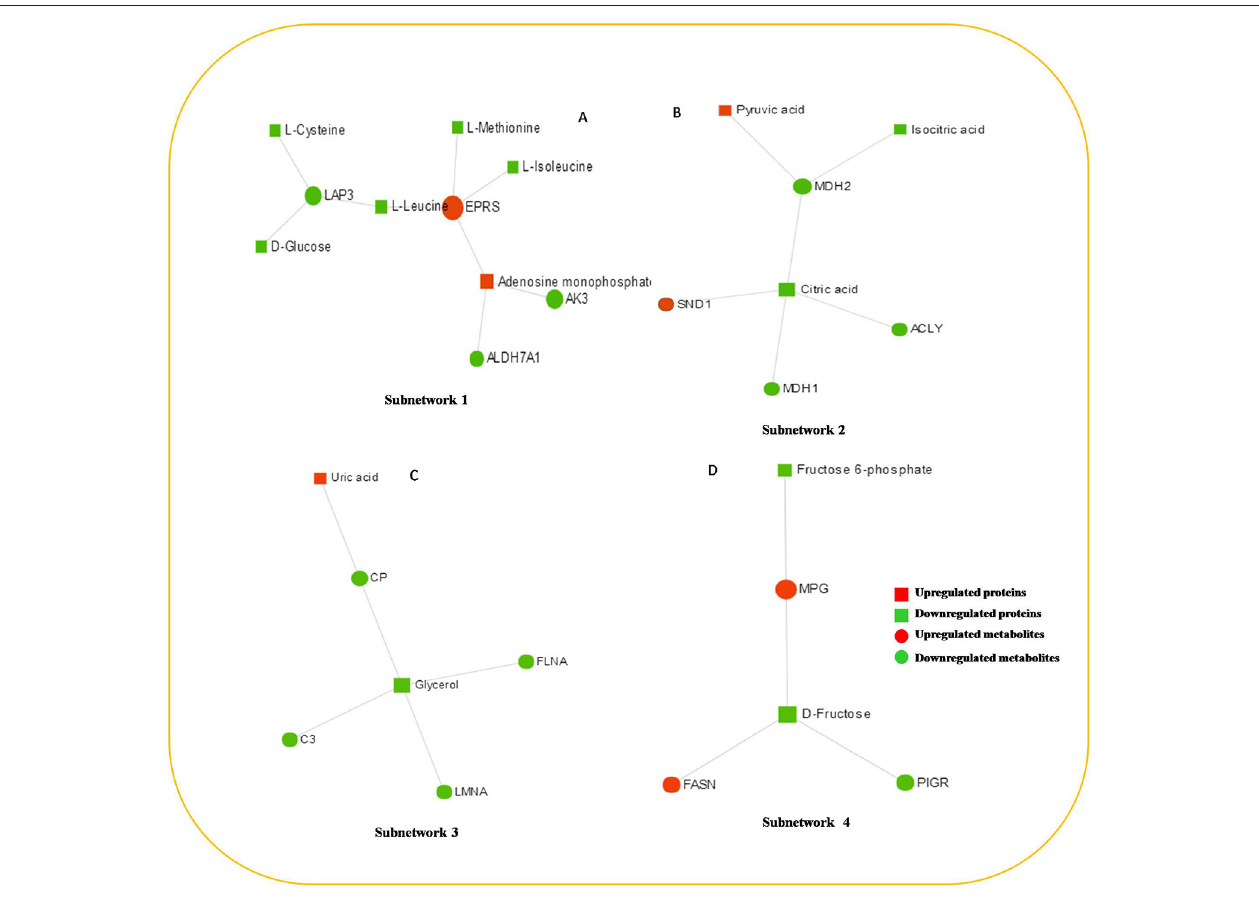
FIGURE 6 | The protein–metabolite interaction network provides a visualization of the interactions between functionally related metabolites and genes (proteins) identified from proteomics and metabolomics. (A) Subnetwork 1, (B) Subnetwork 2, (C) Subnetwork 3, (D) Subnetwork